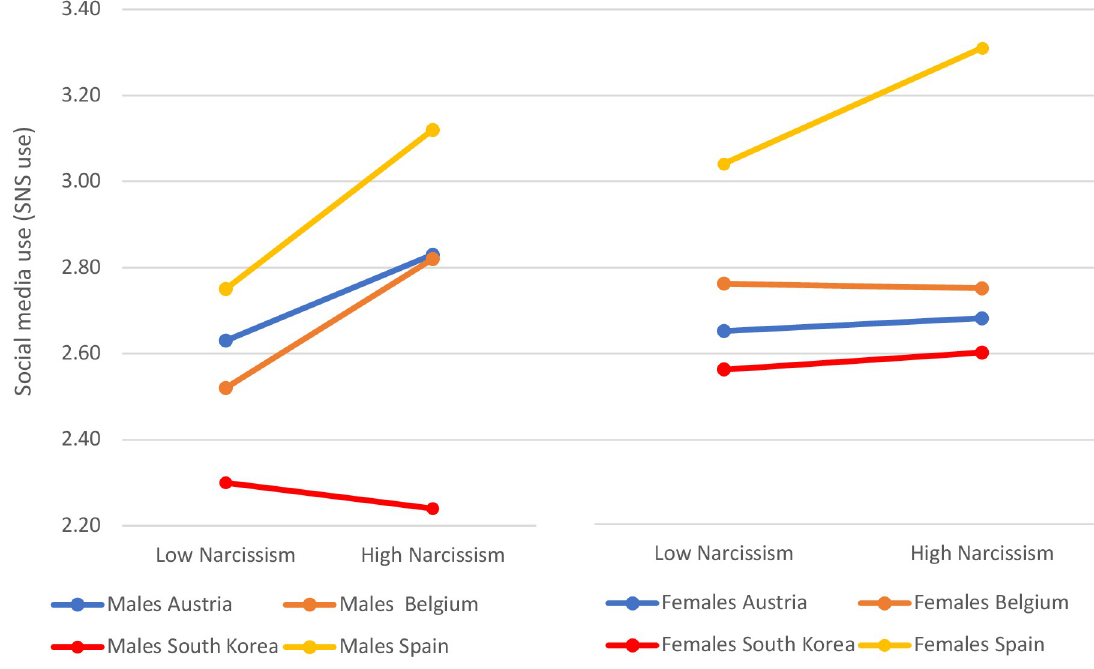
Fig 3. Social media use (SNS use) by gender, narcissism, and country.